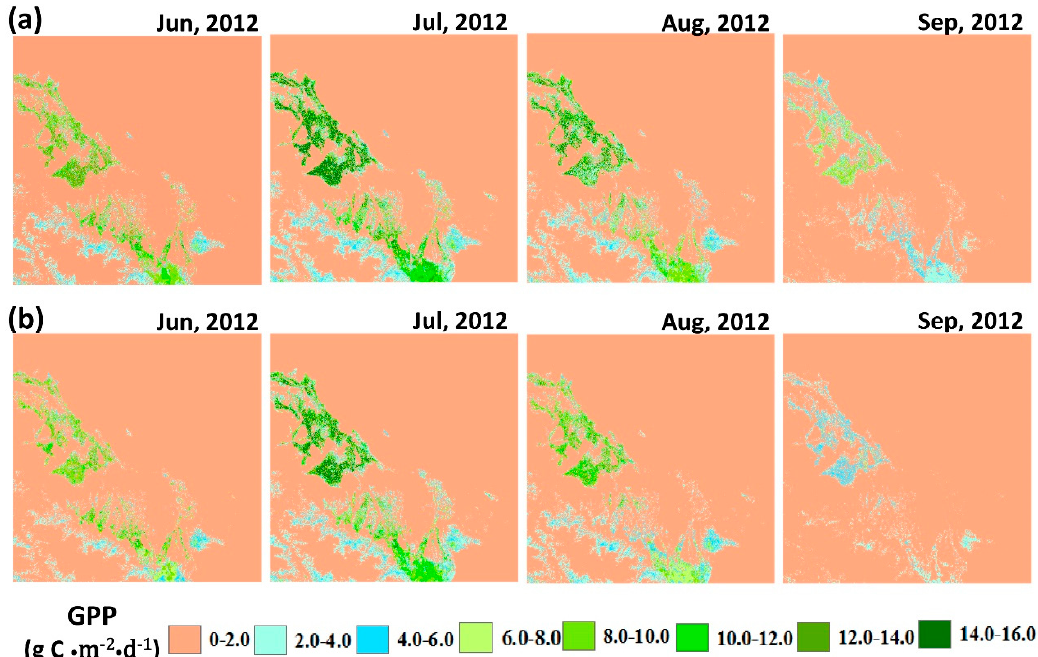
Figure 10. Spatial distribution of 30 m GPP: ( a ) D_GPP_GLASS; ( b ) D_GPP_MODIS. Remote Sens. 2018 , 10 , x FOR PEER REVIEW